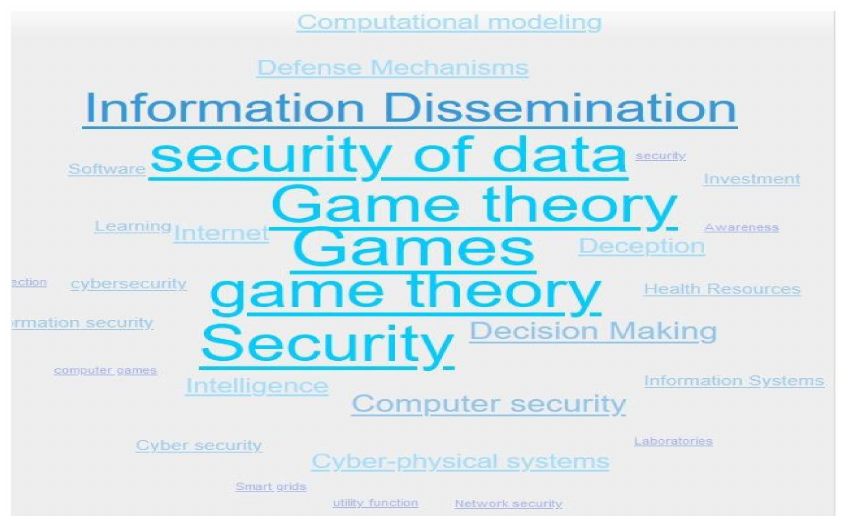
Figure 10. Game theory research